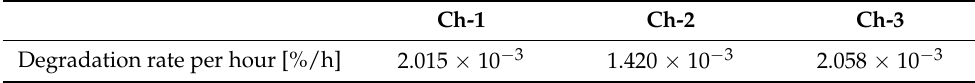
Figure 4. Calibration coefficient values according to the cumulative operation time of the pumps: ( a ) P-1; ( b ) P-2; ( c ) P-3. Table 6. Performance degradation rate of gas absorption chiller-heater.